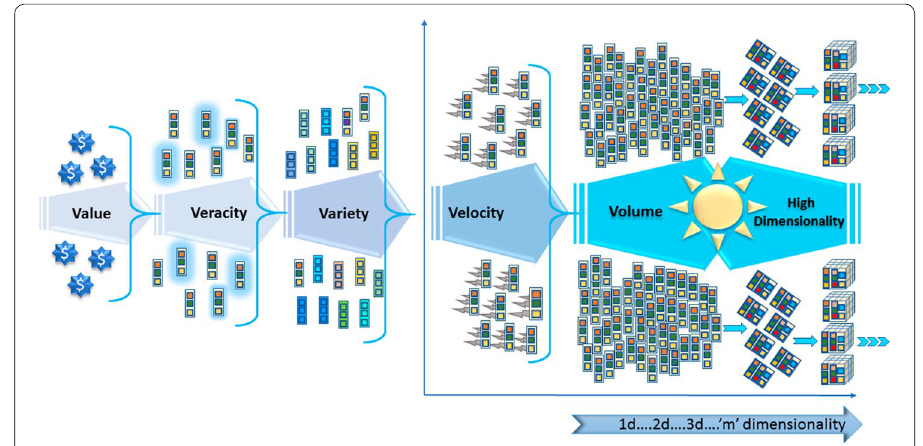
Fig. 1 The high dimensionality problem in big